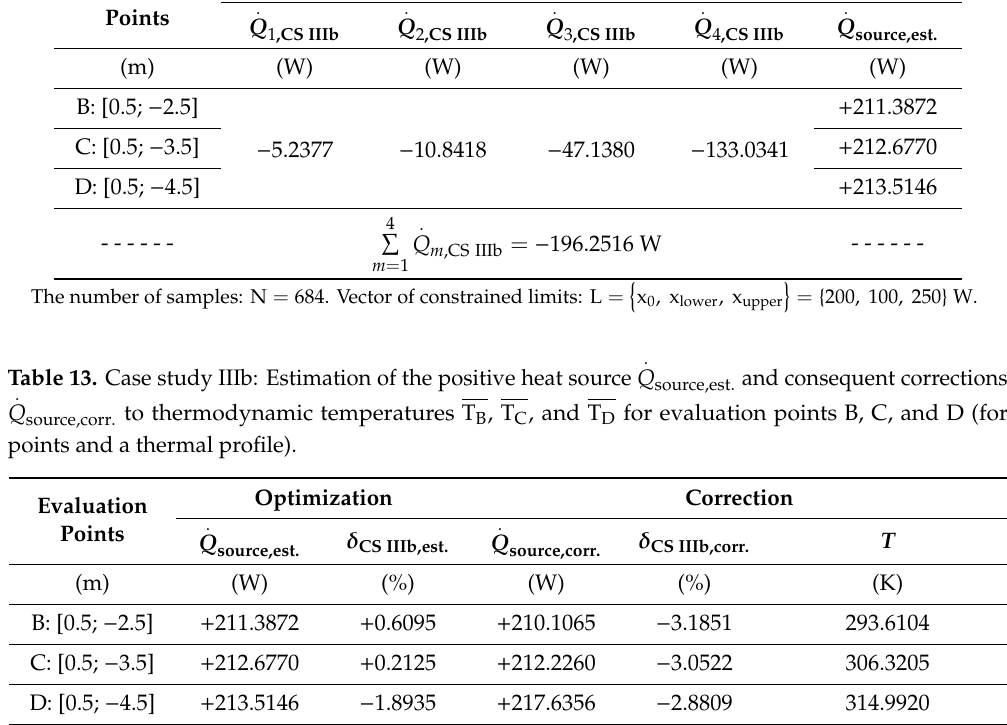
. . Q 1,CS IIIb and Q 4,CS IIIb for evaluation points B, C,